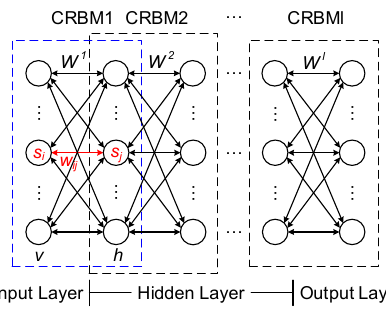
Figure 1. CDBN model structure.